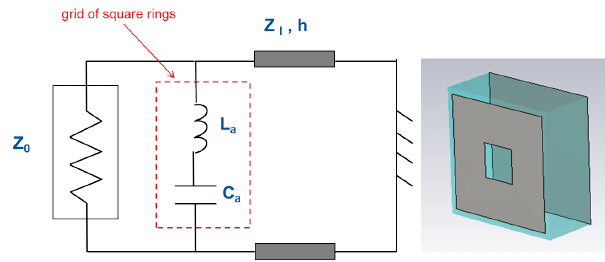
FIGURE 1. SIS unit-cell